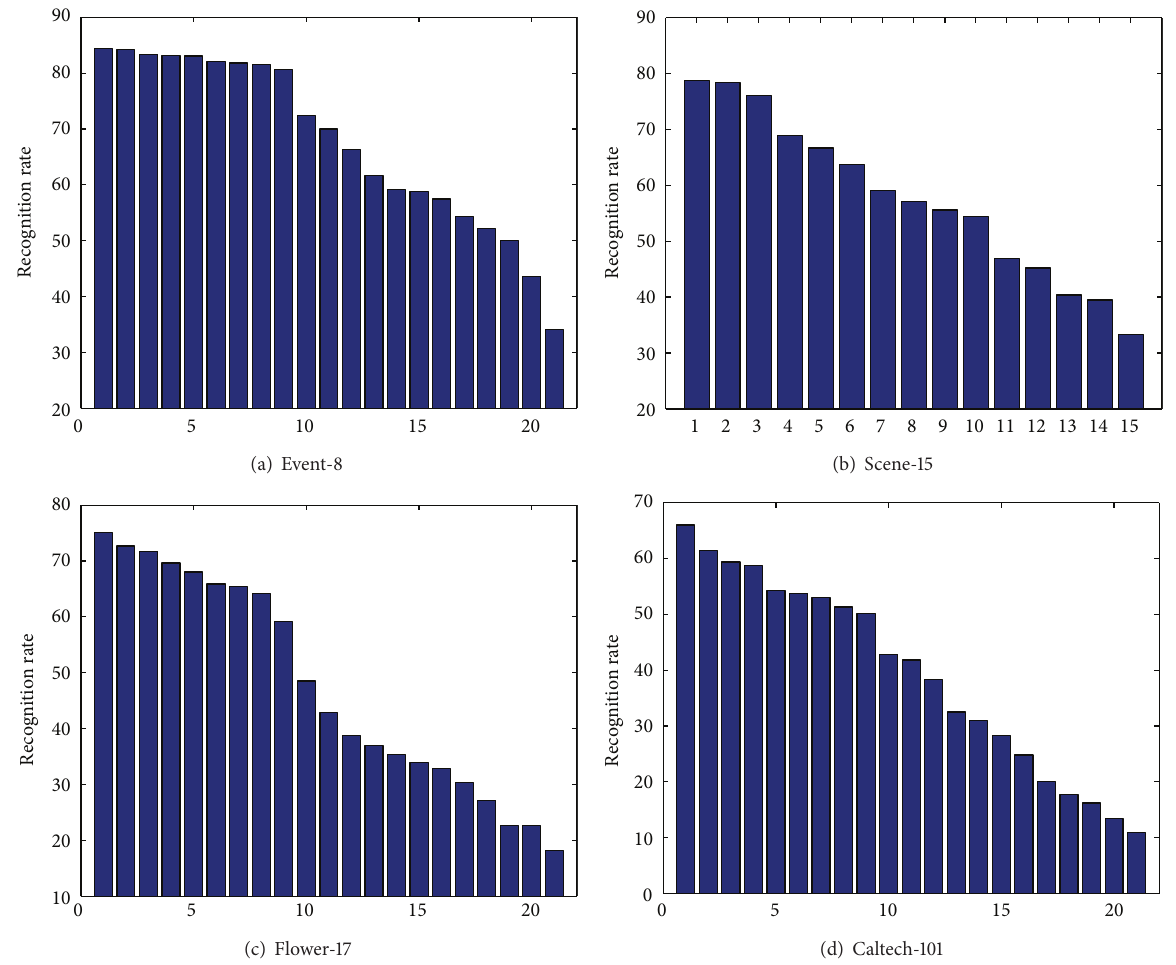
Figure 3: The cross-validation accuracy of individual features used in average